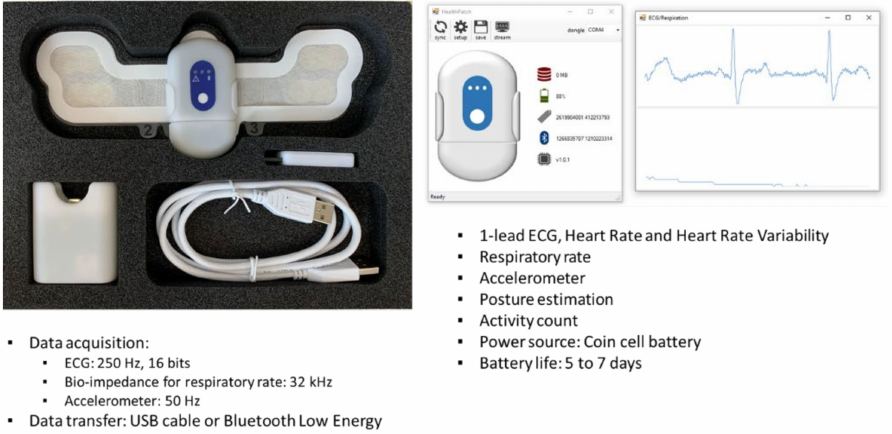
Figure 1. Photo of the wearable 3-in-1 sensor patch for measuring heart and respiration rates, and activity simultaneously (Source: TNO Holst Centre, The